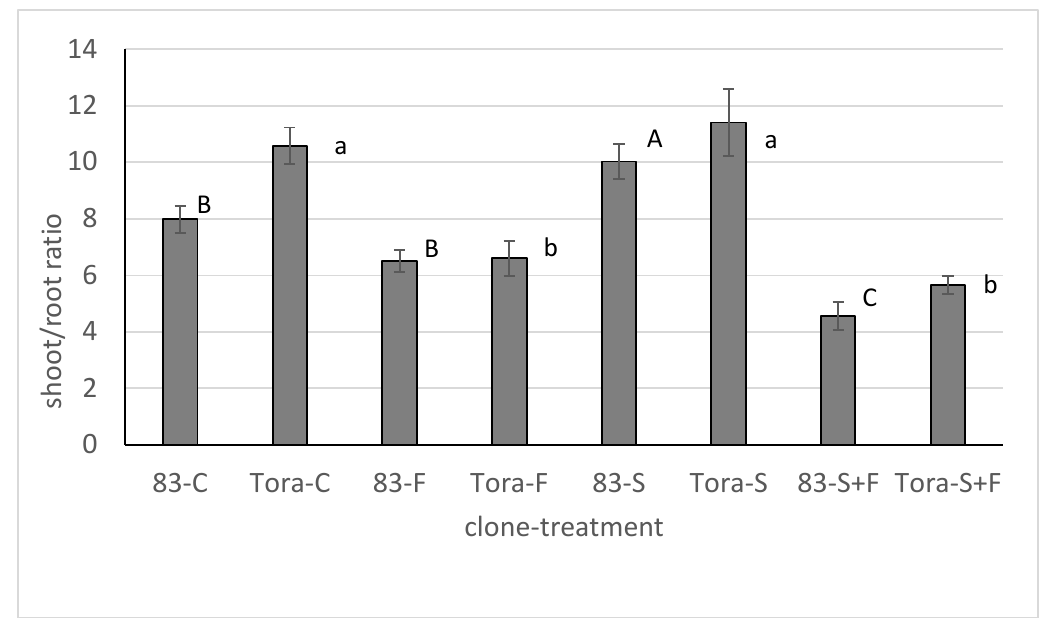
Figure 3. The average ratio between cuttings’ shoot and root biomass productions of various clones and treatments at the end of the experiment in 2009 (C—control; F—fertilizer, S—soil; S+F—soil and fertilizer). The bars represent SE ( n = 14–15). The particular clone values with distinct letters (capitals for clone 83 and lowercase for clone Tora) differ from each other significantly (REGW test).